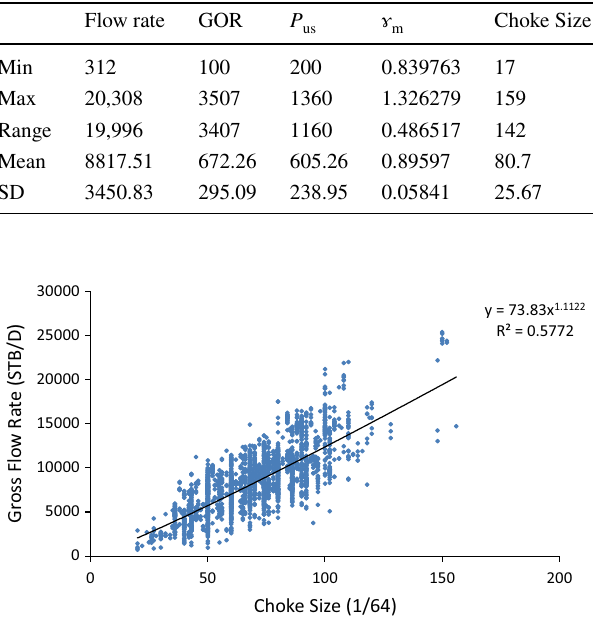
Table 1 Input and output data statistical analysis